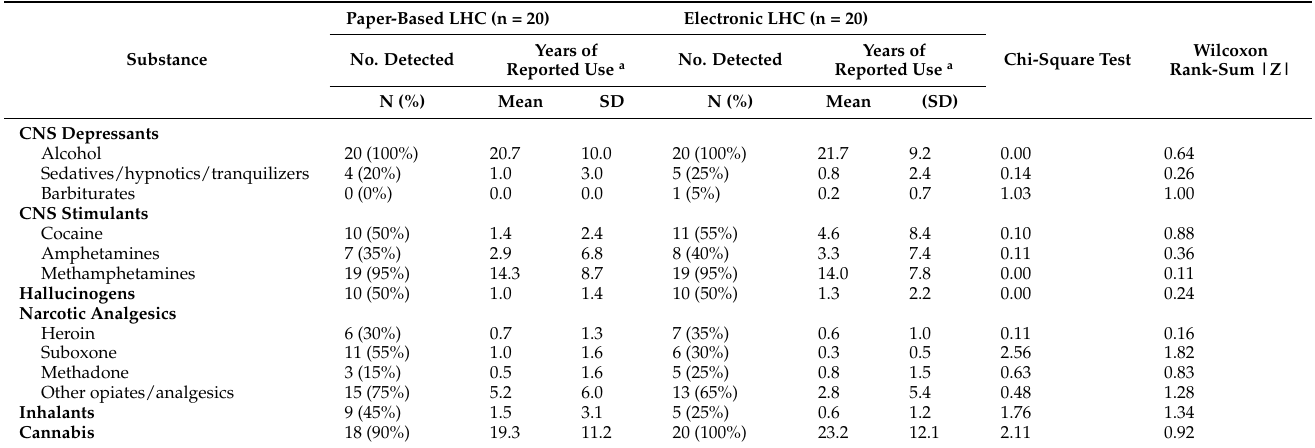
Table 3. Substances reported by modality of LHC administration (paper versus electronic) in a sample of Indigenous people who used injection drugs, n =